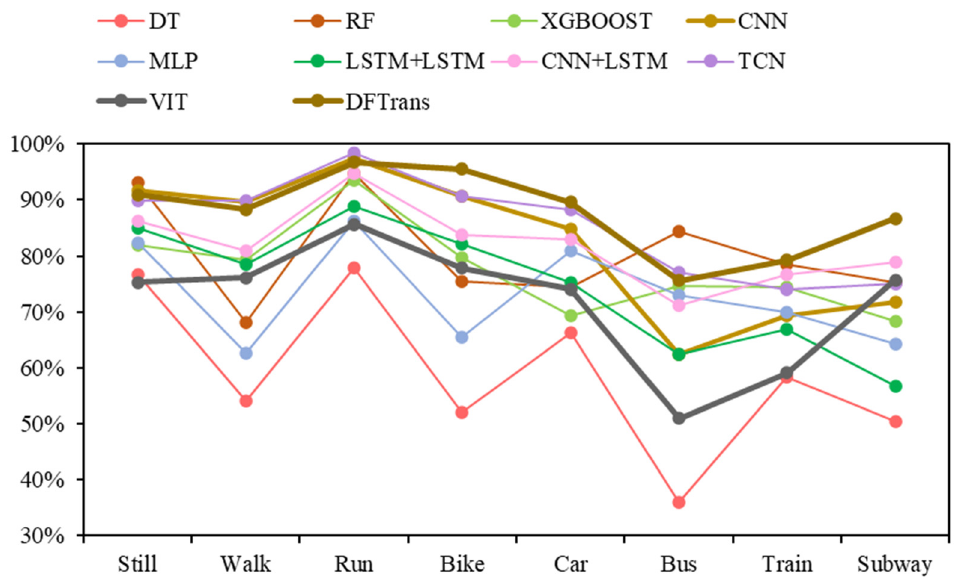
Figure 10. Variation in the performance of nine baselines and the DFTrans algorithm on eight trans- portation mode detection on the HTC dataset.